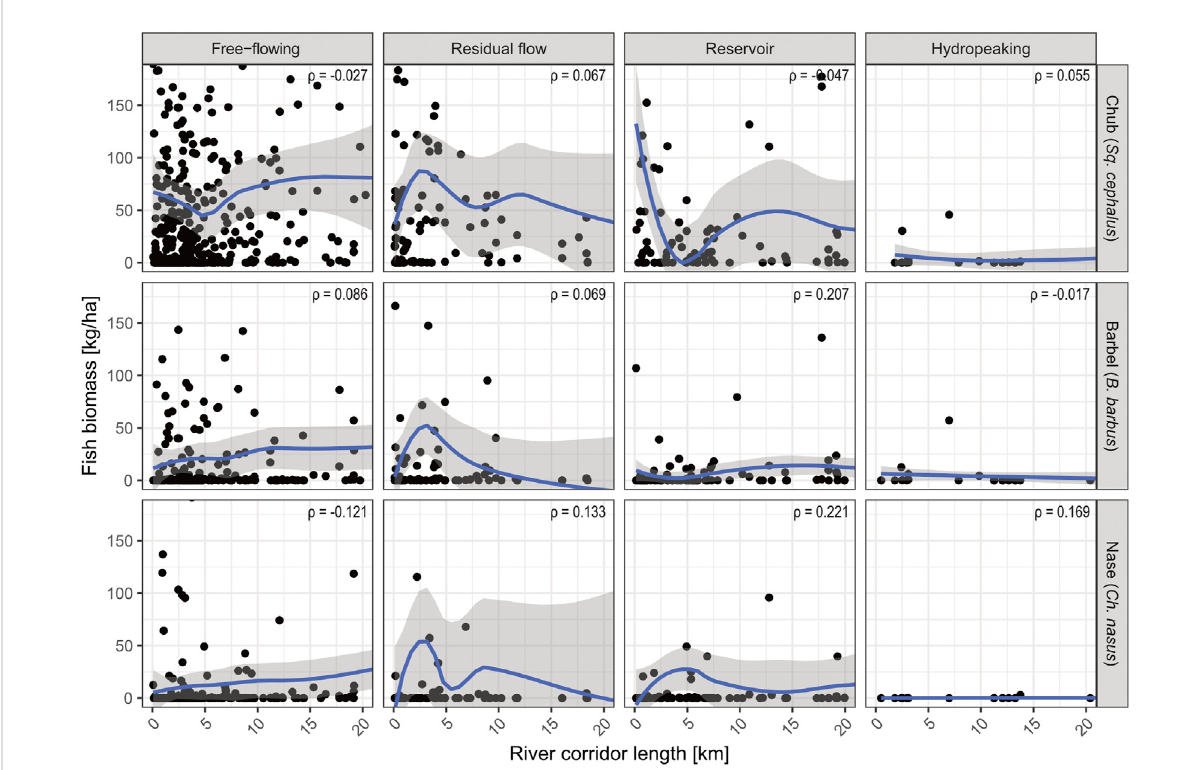
FIGURE 4 Scatterplot of fi sh biomass [kg/ha] and river corridor length [km] for each of the three target species. The shown curve is a LOESS interpolation. Siteswithacorridorlength > 20 kmandabiomass > 180